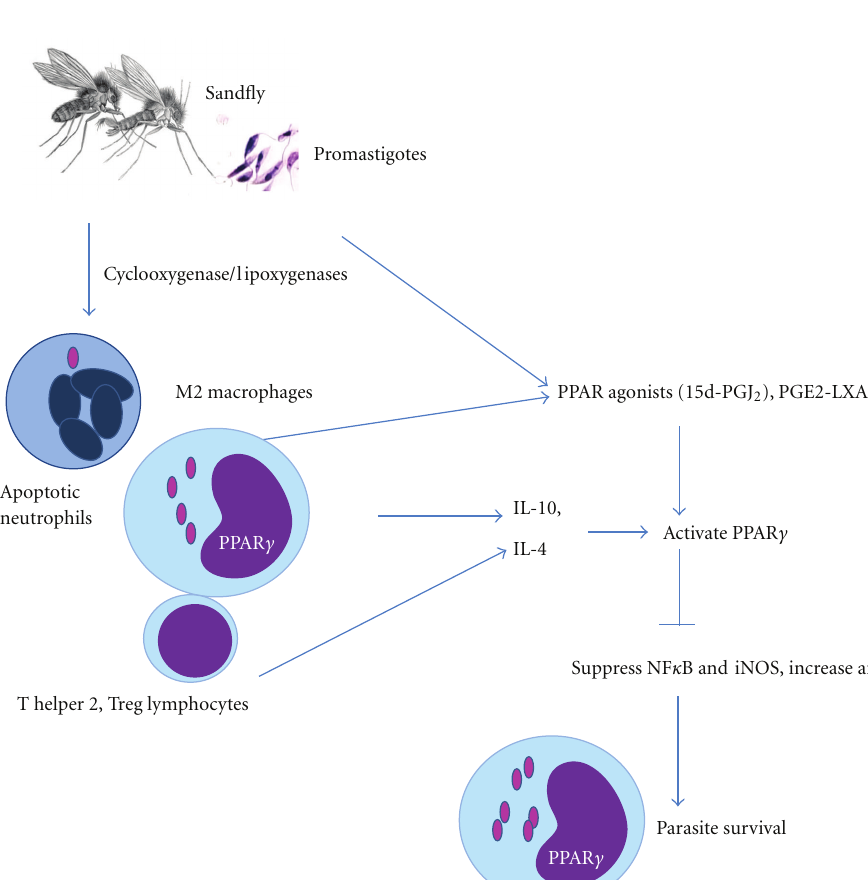
Figure 8: Scheme of Leishmania interaction with mediators of the resolution process during inflammation. When infected sandflies bite, promastigotes enter the neutrophils and macrophages that are recruited to the inflamed site of injection. The parasite can, by itself, activate the infected host cells to produce PPAR activators. This includes PPAR γ agonists such as the bioactive lipids 15d-PGJ 2 and LXA 4 from the arachidonic acid pathways. Engulfment of apoptotic neutrophils and IL-4 from T helper 2 cells can activate PPAR γ as well. Activation of PPAR γ polarizes the host macrophage towards the alternatively activated macrophage (M2) phenotype, which would produce arginase to divert substrate from iNOS and thus reduce the production of nitric oxide. As such, the parasite can survive and multiply within the host’s macrophages, and the infection becomes